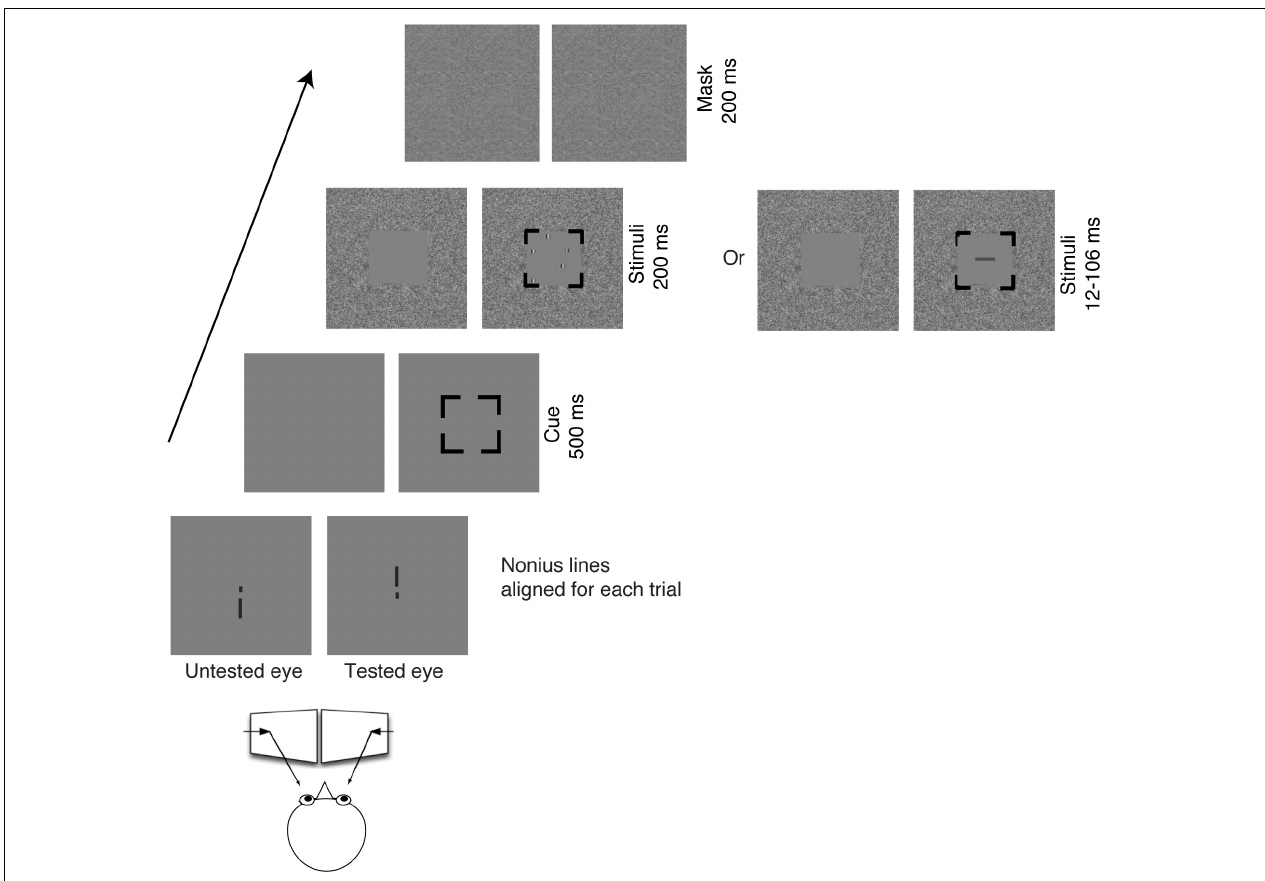
FIGURE 1 | Illustration of the stimuli and the temporal sequence of a given trial viewing through a mirror stereoscope. In Experiment 1, the targets (Gabors) were presented to the same eye within a block. In Experiment 2, the targets (Gabors) were randomly presented to the left eye or to the right eye within a block. The task for Experiments 1, 2 was to count the number of Gabors. In Experiment 3, the target (a rectangle in horizontal or vertical orientation) was randomly presented to the left eye or to the right eye within a block with a wide range of display durations between 12 and 106 ms. The task for Experiment 3 was to report the orientation of the